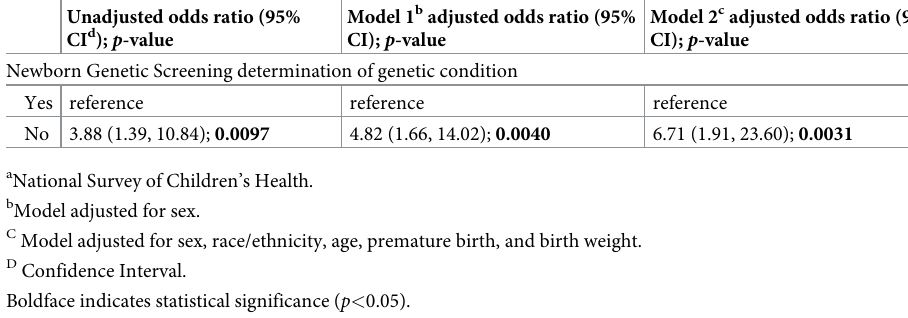
Table 3. Difficulty receiving needed specialist care and newborn genetic screening determination of genetic condi- tion, NSCH, a 2020. Unadjusted odds ratio (95% CI d ); p -value Newborn Genetic Screening determination of genetic condition